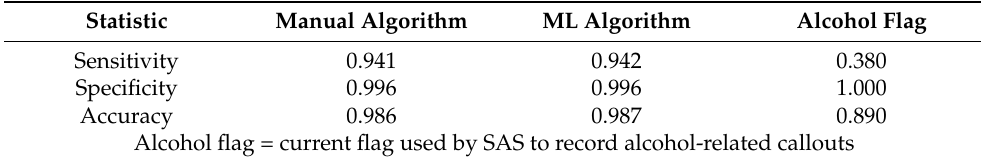
Table 2. Algorithm performance, including alcohol flag.